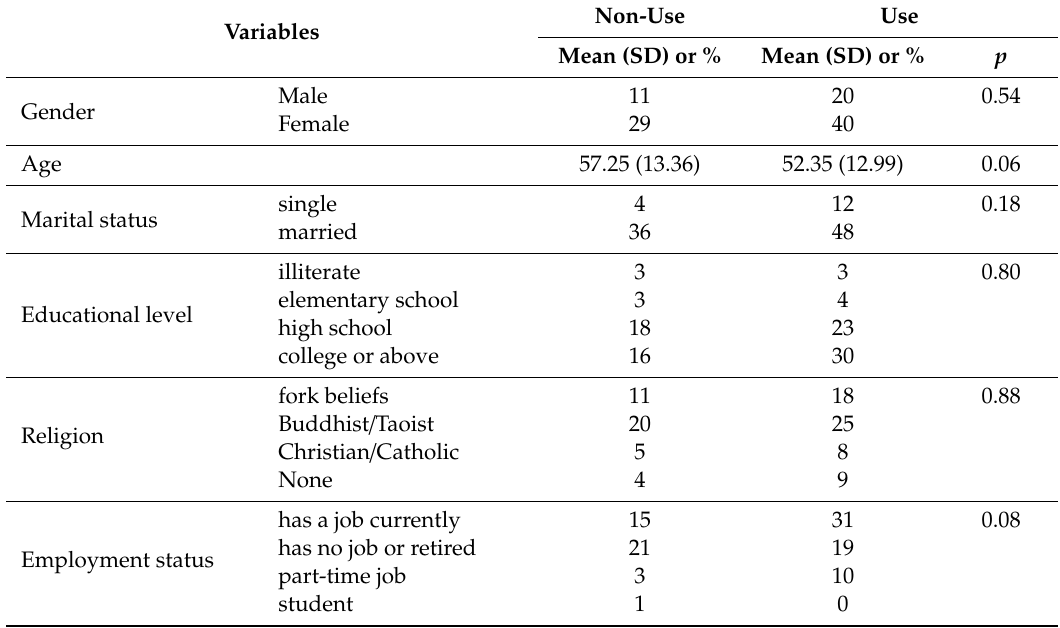
Table 4. The factors related to the di ff erence of caregivers use or non-use of long-term care